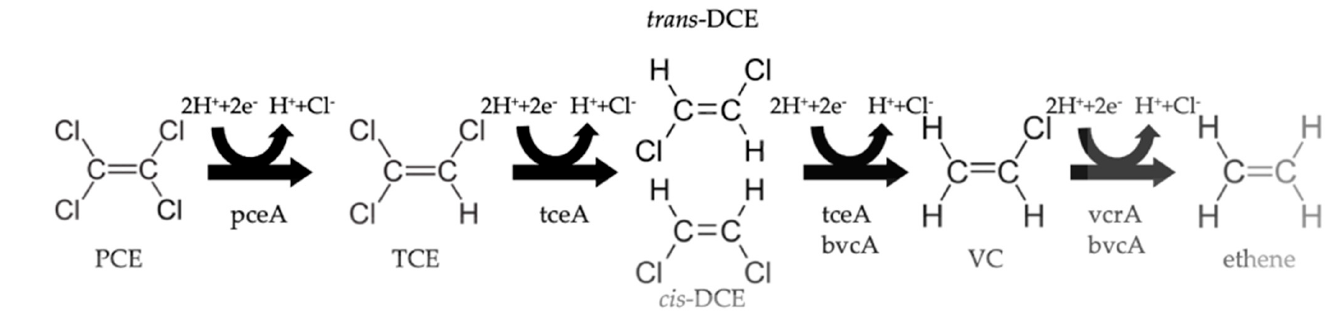
Figure 2. Anaerobic respiration pathway: organo − halide dechlorination of PCE to ethene and respective enzymes involved in the process: PCE reductase pceA, TCE reductase tceA, DCE/VC reductases bvcA, and vcrA. Modi fi ed from [35].